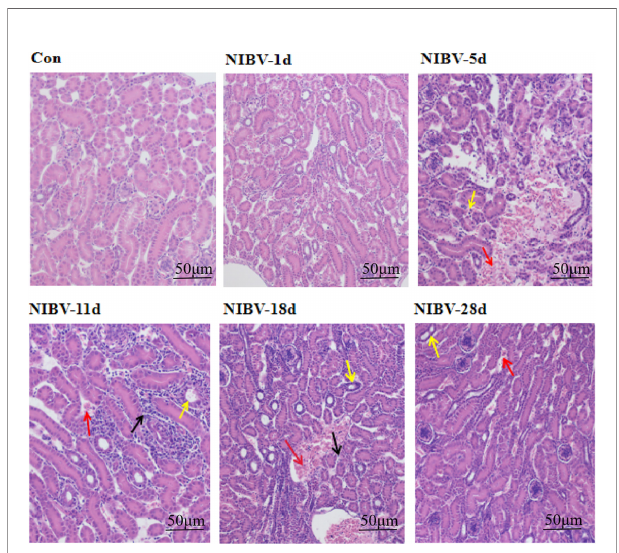
FIGURE 2 | Histopathological changes in the kidneys (H&E staining), the red arrow indicates renal hemorrhage, the black arrows indicate in fl ammatory cell in fi ltration; the yellow arrows indicate the absence of tubular ( Figure 8A ). IFN- g positive signals were mainly distributed in the nucleus. The positive signal intensity of IFN- g had no signi fi cant change at 1 dpi and decreased signi fi cantly at 5 dpi; after that, the positive signal of IFN- g increased gradually, from